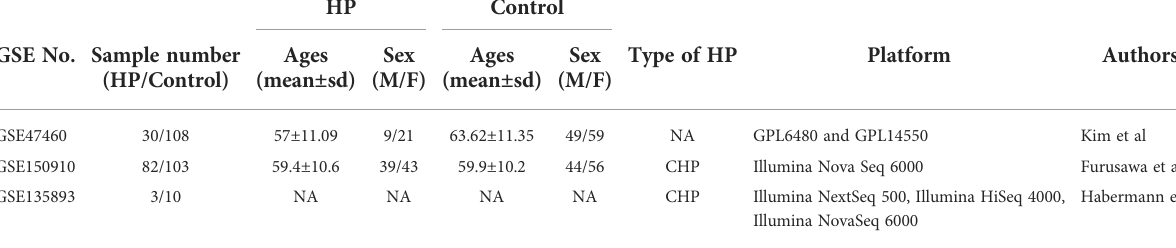
TABLE 4 Summary of those 3 genome-wide gene expression datasets involving HP patients. HP Control